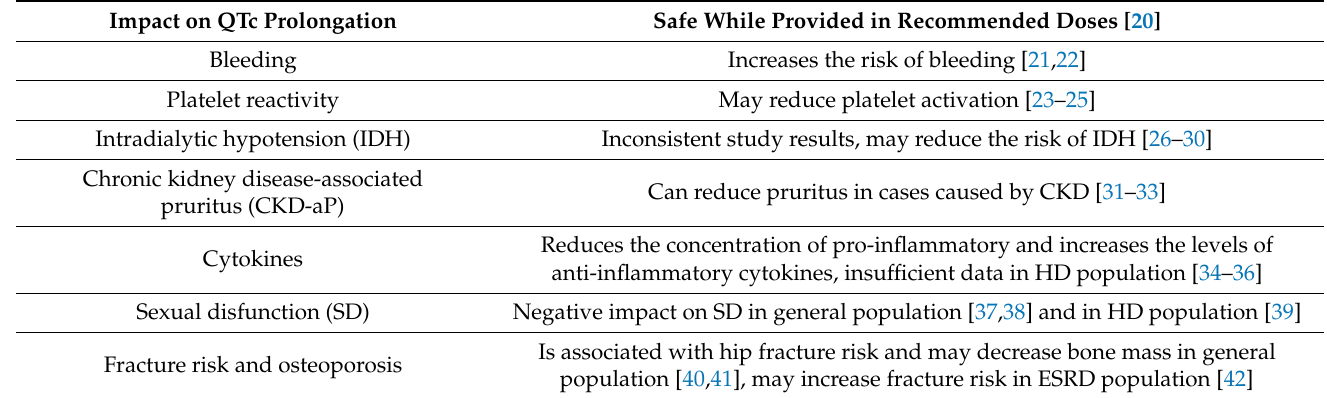
Table 3. Effects of sertraline use in hemodialysis patients.